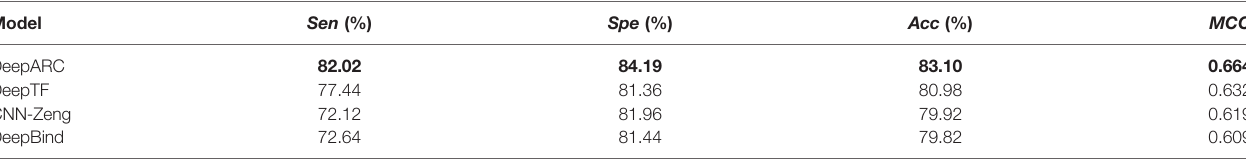
TABLE 4 | Performance comparison of DeepARC and three existing predictors.